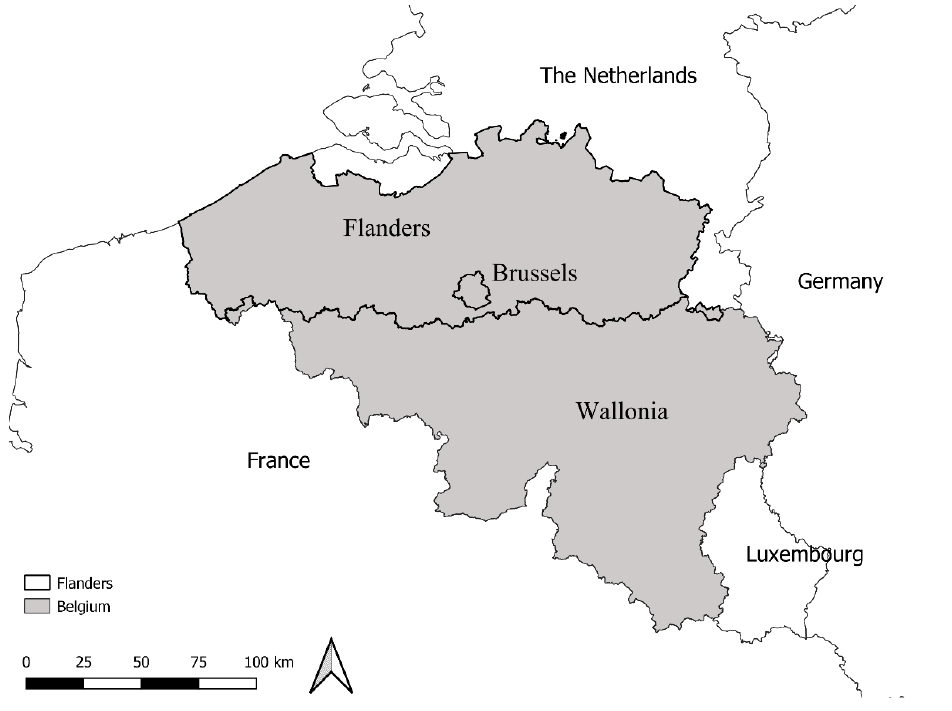
Figure 1: Flanders situated in